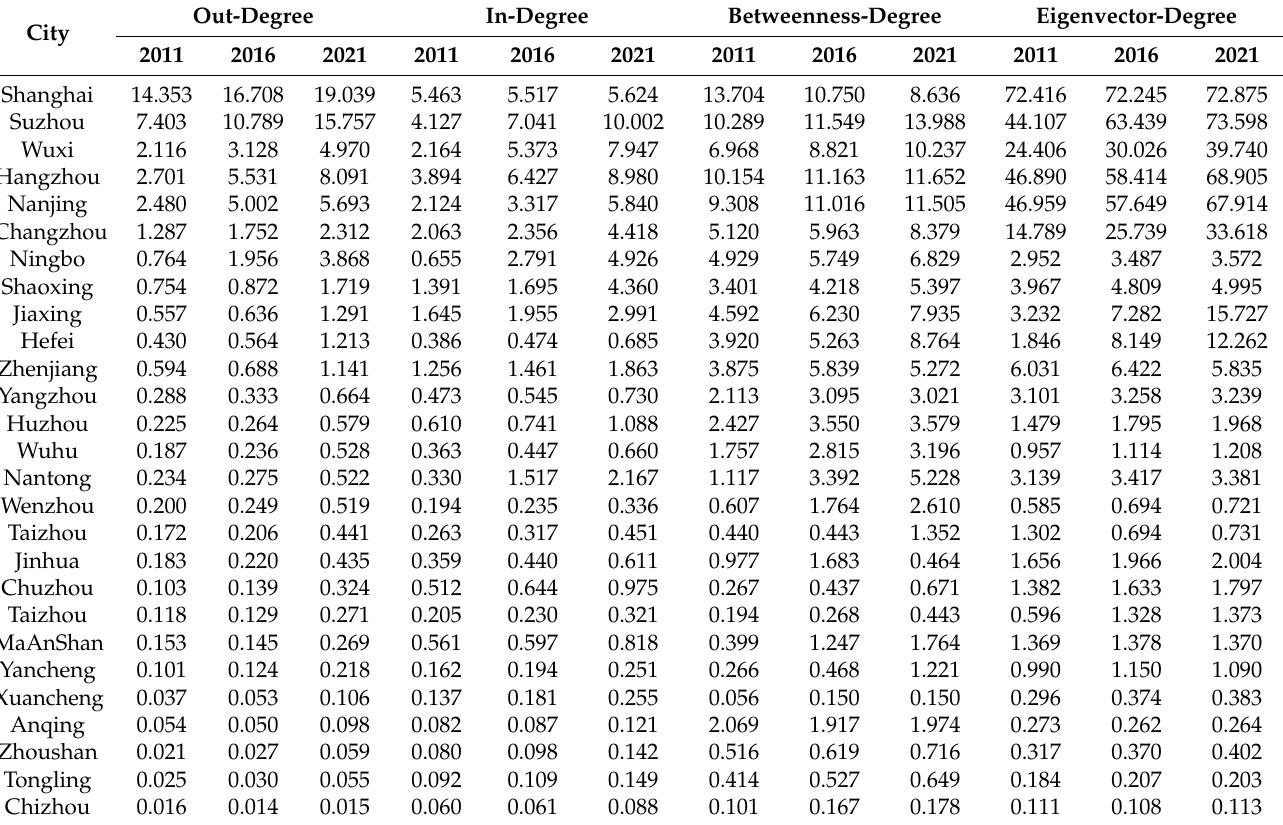
Table 4. Centrality of economic networks in Yangtze river delta.